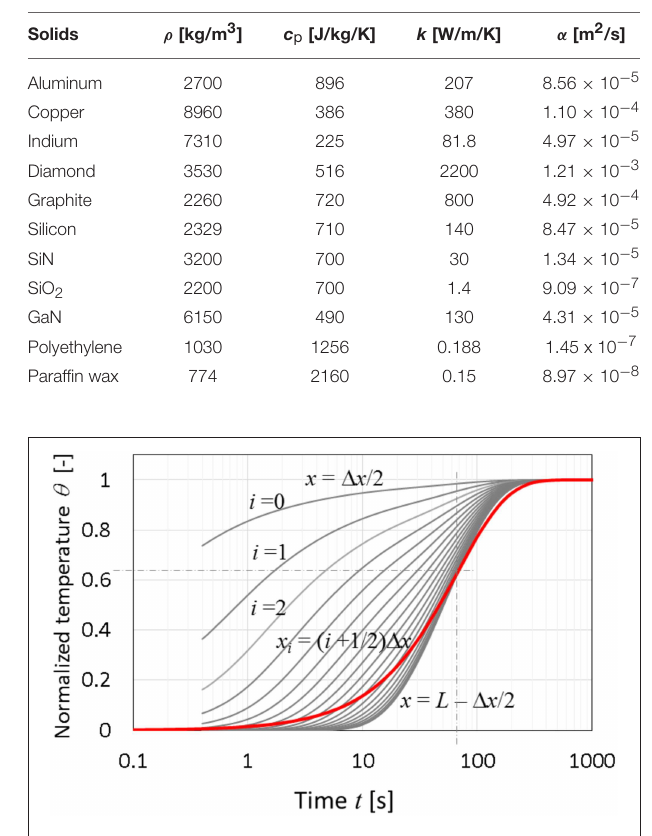
FIGURE 4 | Normalized temperature responses of the discrete model ( n 20). Lumped-mass model in a bold line for solid silicon with a time constant of